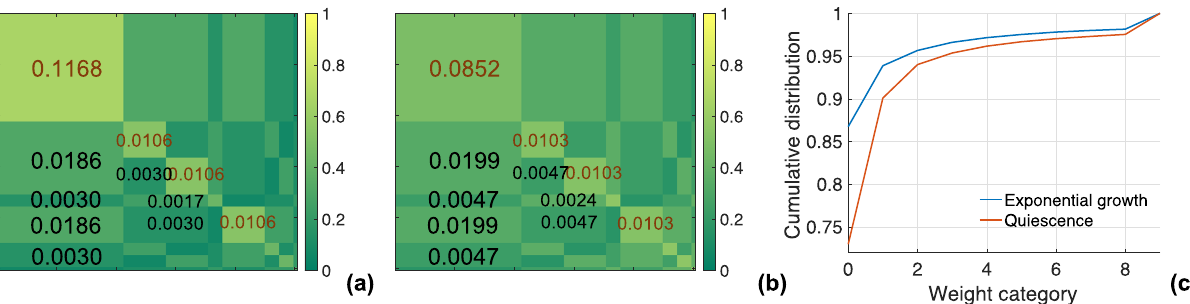
Fig. 8 Weighted-multifractal graph model (WMGM) inference for the yeast genome in different growing states. a Reconstructed WMGM θ K from chromosomal interactions of exponentially growing yeast with model iteration K = 3. We visualized the reconstructed model with the square block. The interval length on square side (x, y axis) is divided by node attribute probability l K and the linking probability value p K of each block is represented by the yellow-green color. Several linking probability values are shown on the block. b Reconstructed WMGM of yeast cell in quiescence state. c Cumulative weight distribution of the interaction maps.